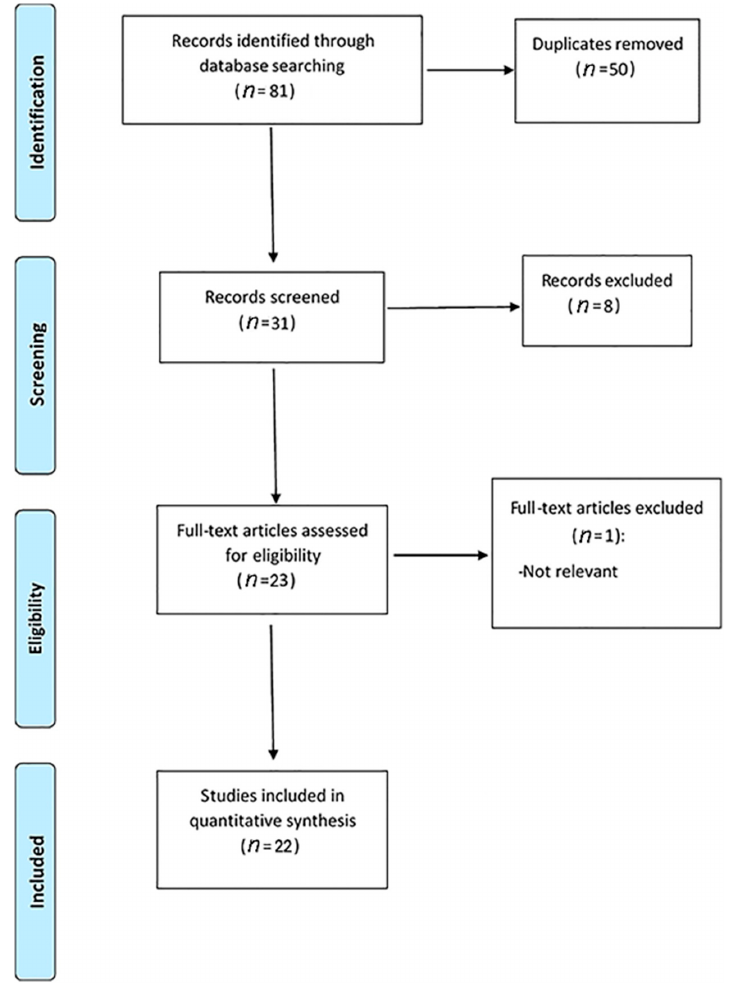
Figure 1. Flowchart of study selection.